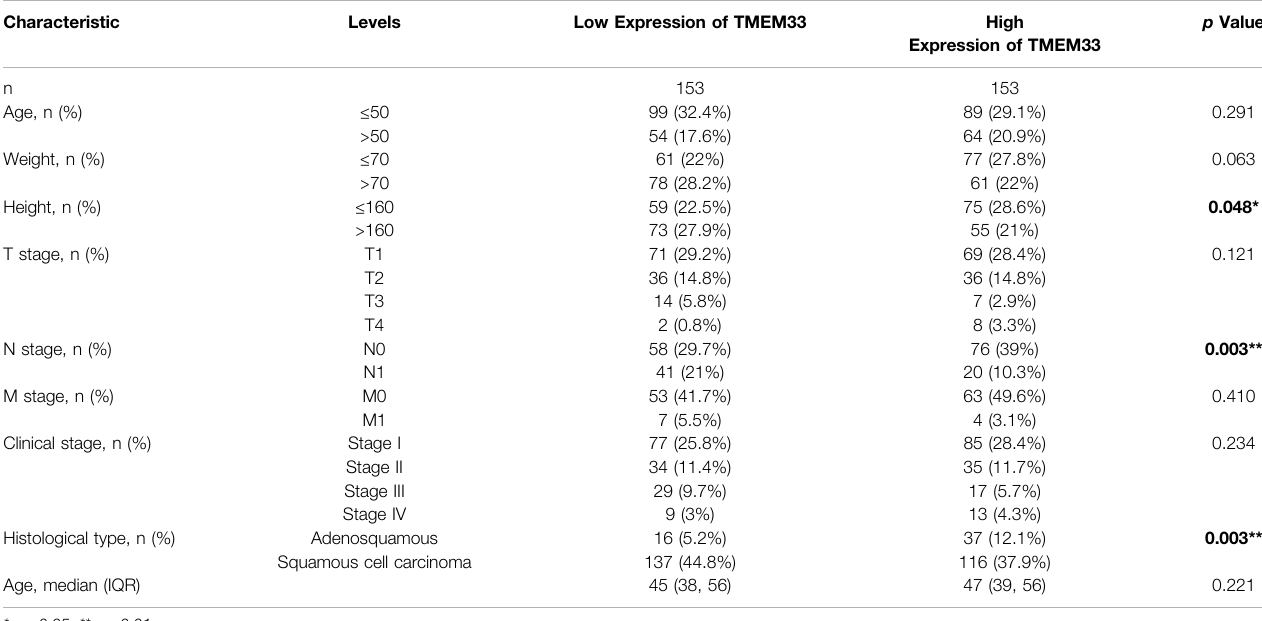
TABLE 1 | Clinicopathological characteristics of CESC patients with differential TMEM33 expression. Characteristic